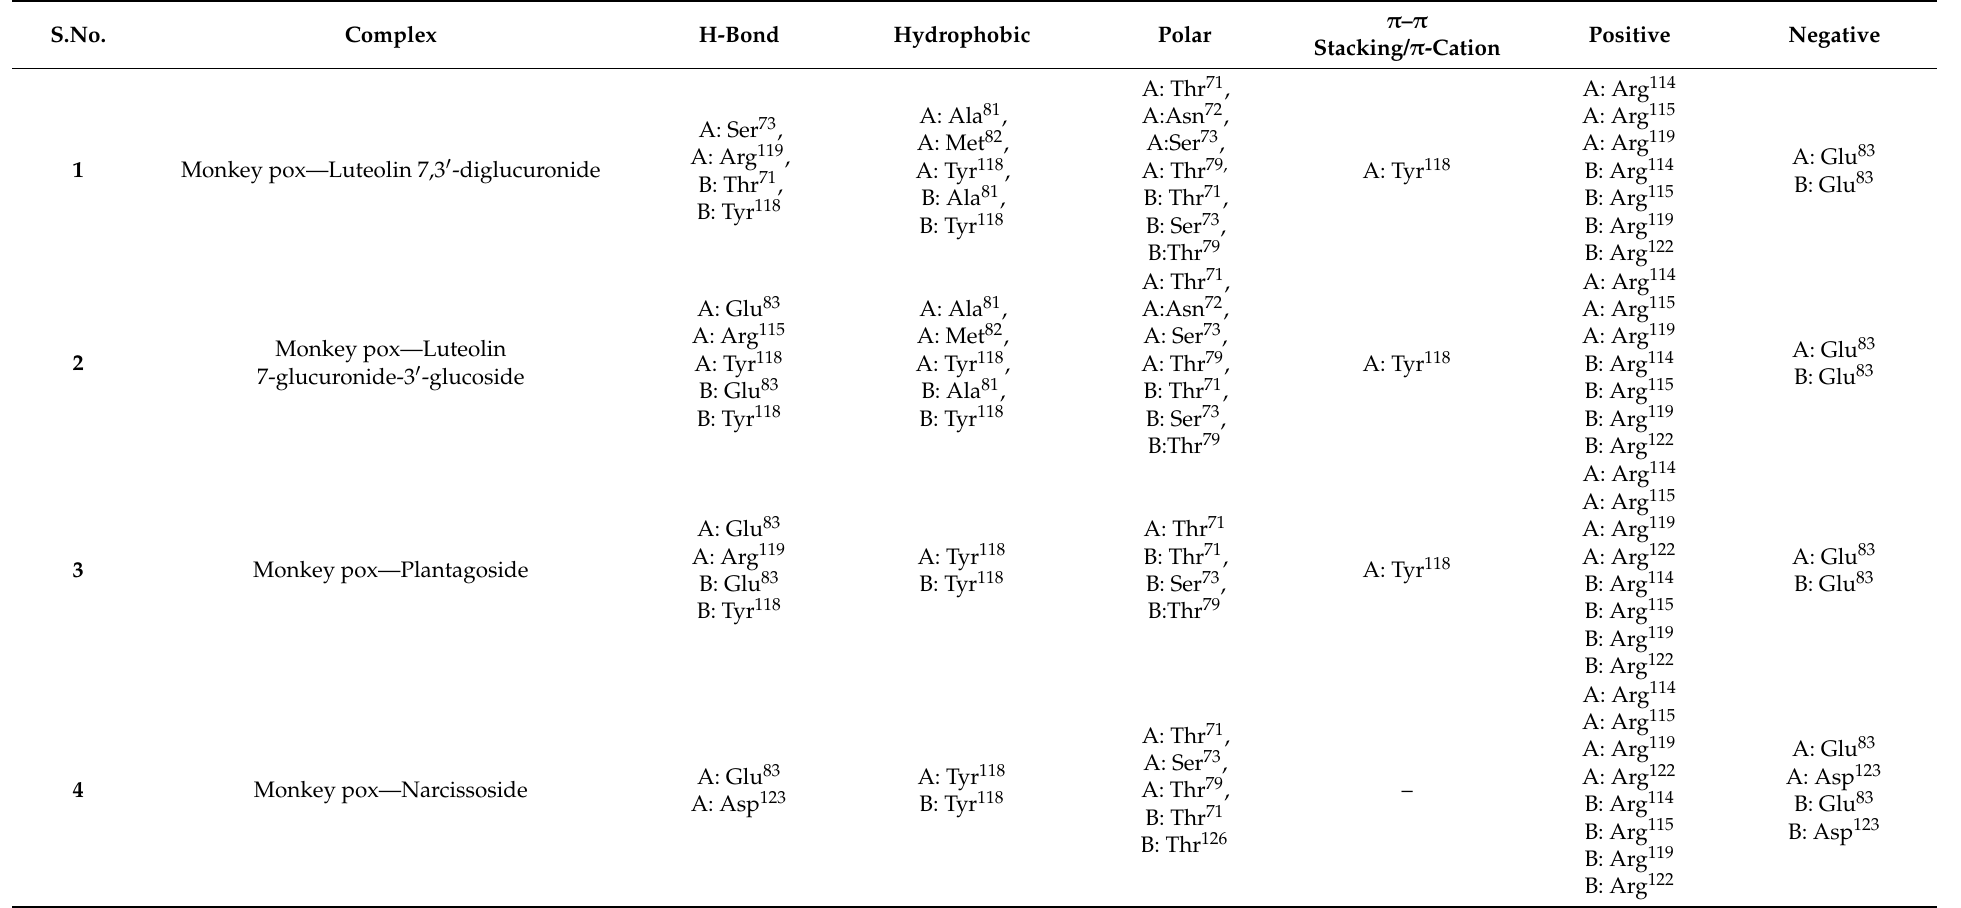
Table 3. List of interacting residues and type of interactions for A42R protein of MPXV with the top five hits and reference molecule PE8. S.No.